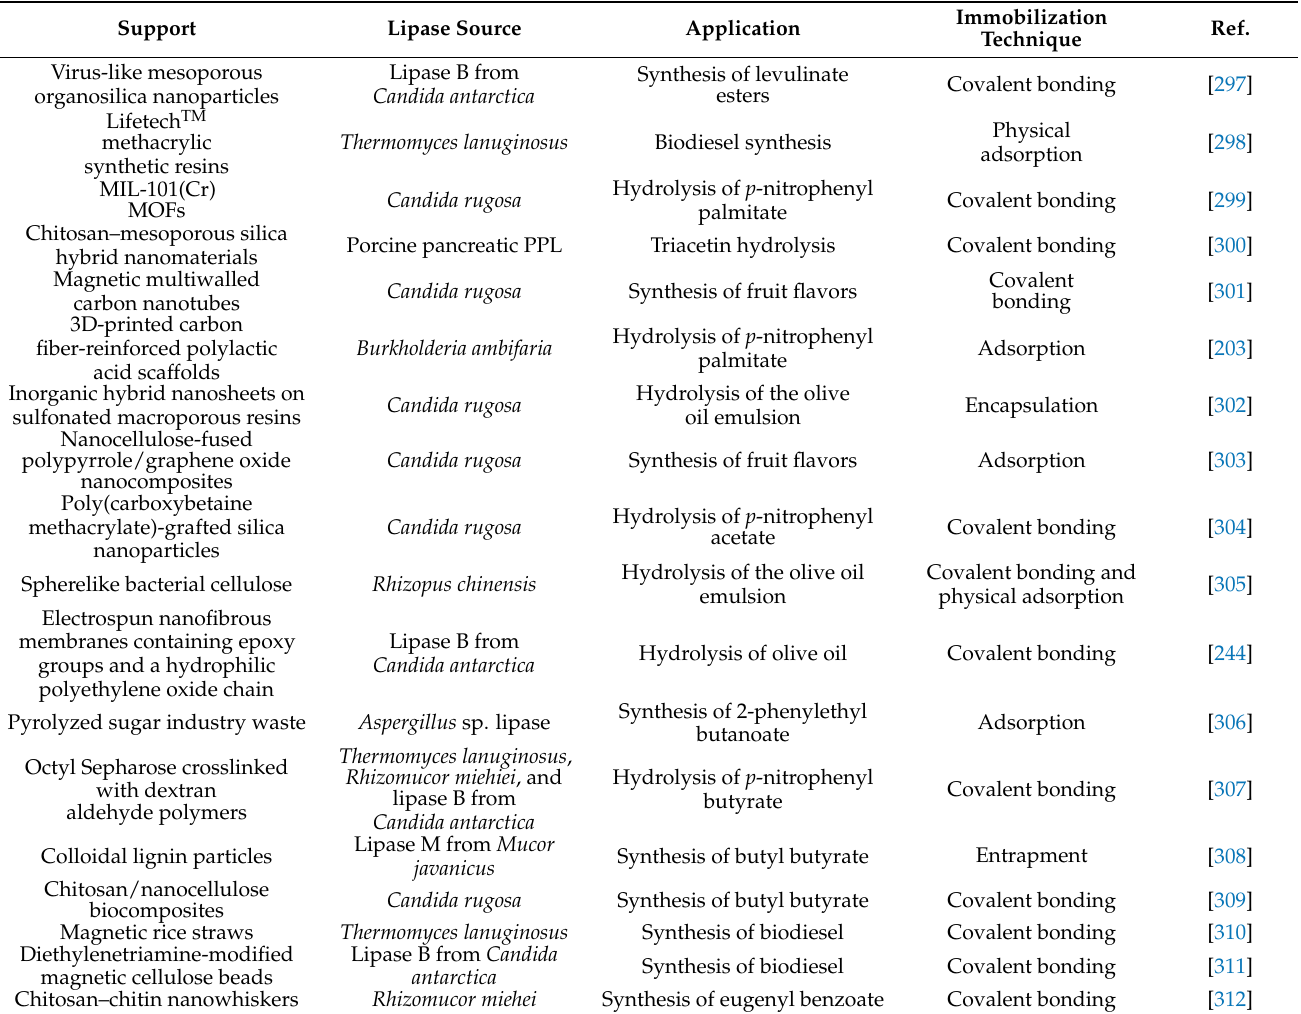
Table 1. Novel research in lipase